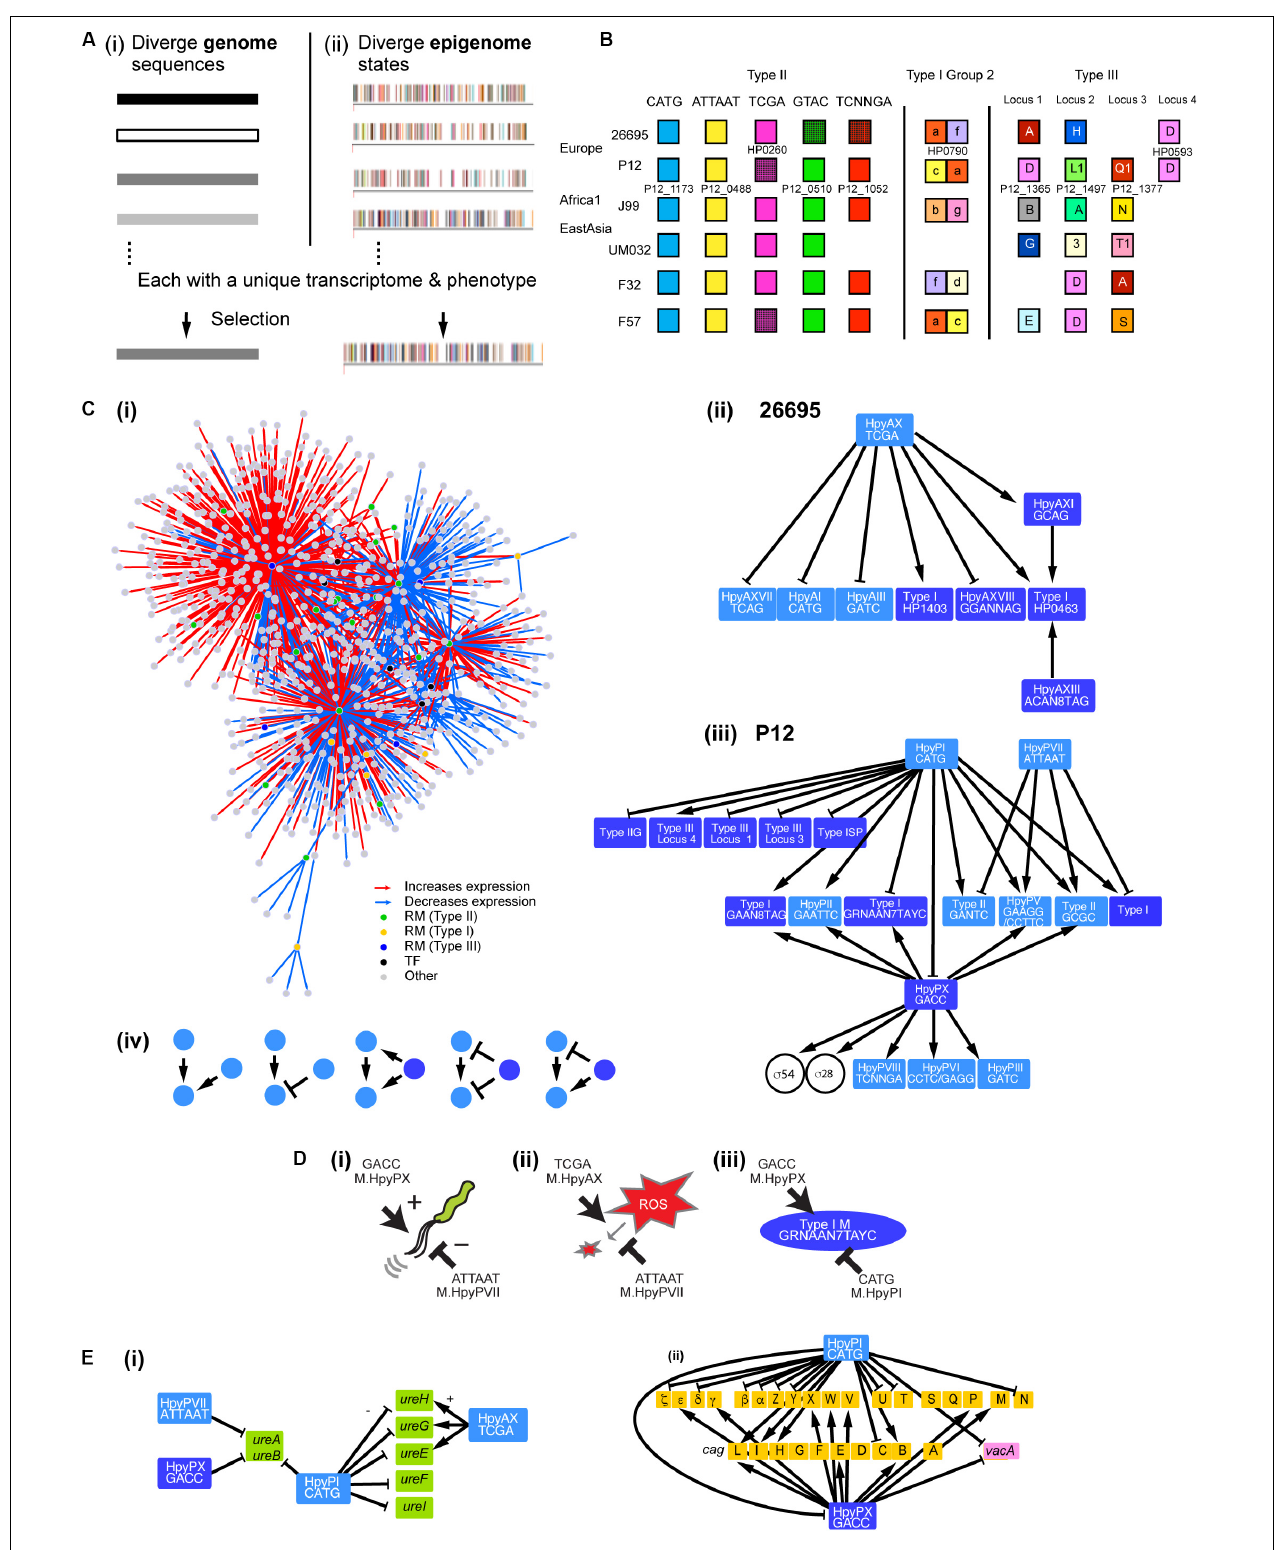
FIGURE 1 | Gene regulation network involving multiple DNA methyltransferases. (A) Two models for adaptive evolution. (i) Genome-based. (ii) Epigenome-based model with a part of the methylomes ( rpoB , top strand) of closely related H. pylori strains [modified from Furuta et al. (2014)]. One bar indicates one methylation